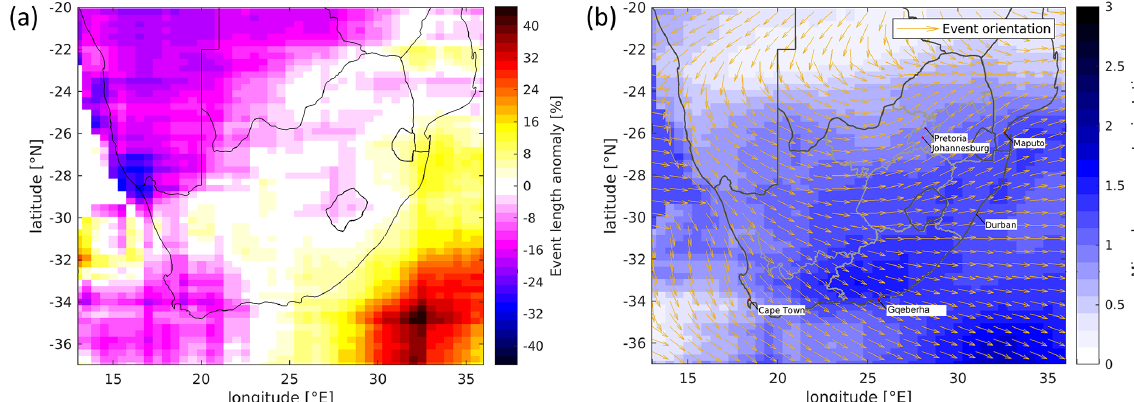
Figure 11. (a) Spatial variation of mean event length (%) and (b) spatial variation of event orientation, location parameter (arrows), and the shape parameter κ of the von Mises distribution derived from the observed OT